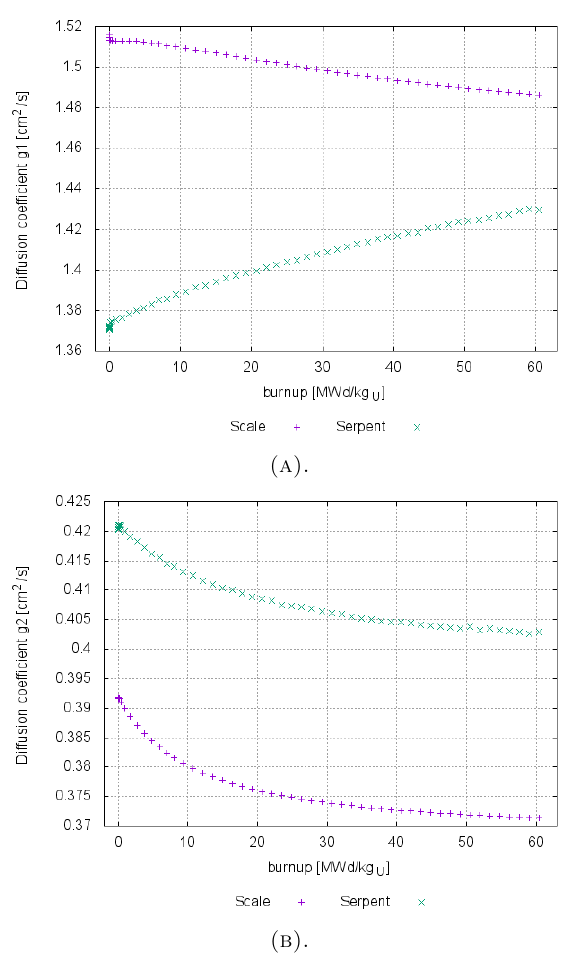
Figure 4. Diffusion coefficient dependency on burnup for fast group (a) and for thermal group